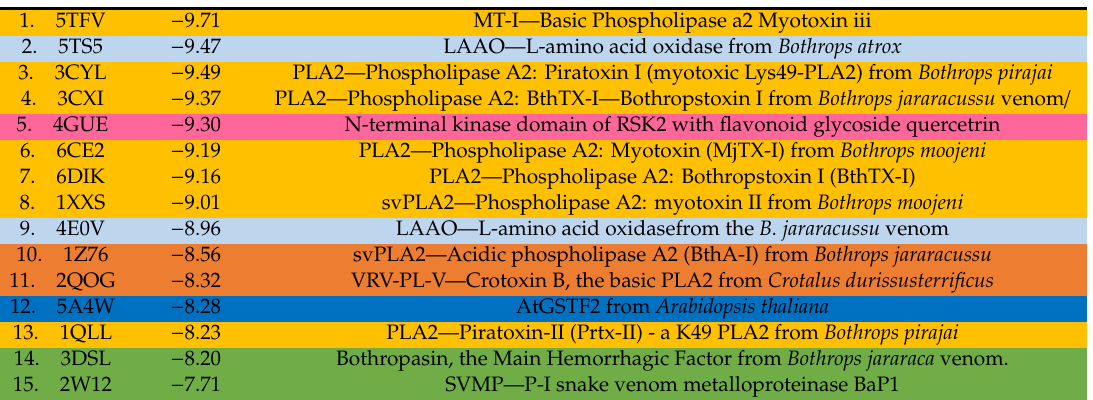
Table 3. The liaison energies of quercetrin with the PDB ID studied